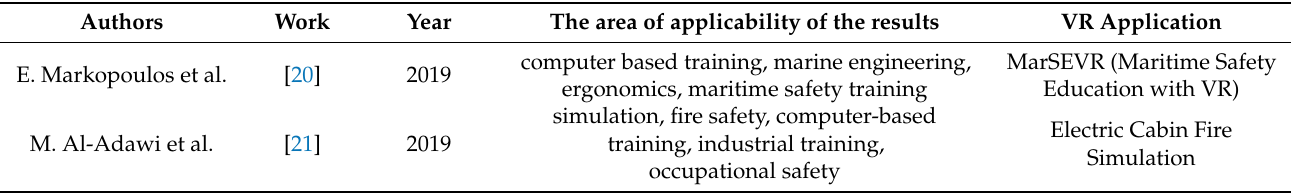
Table 3. The area of applicability of the results of the reviewed literature and the applied virtual reality (VR) applica-